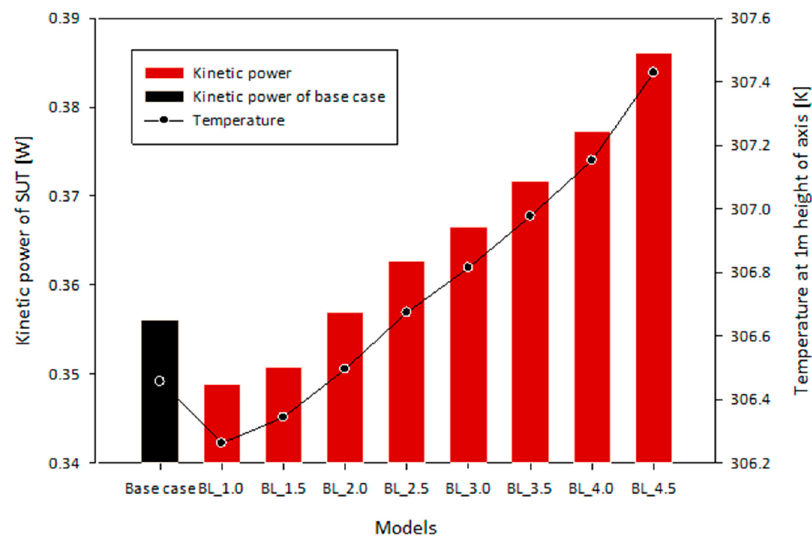
Figure 7. The kinetic power and temperature of each case at the height of 1 m of central axis: The black bar is the kinetic power of the base case, and the red bars are the kinetic power of models with a baffle of which the values are on the left y-axis. The line graph along the dots indicates the temperature of which the values are on the right y-axis.